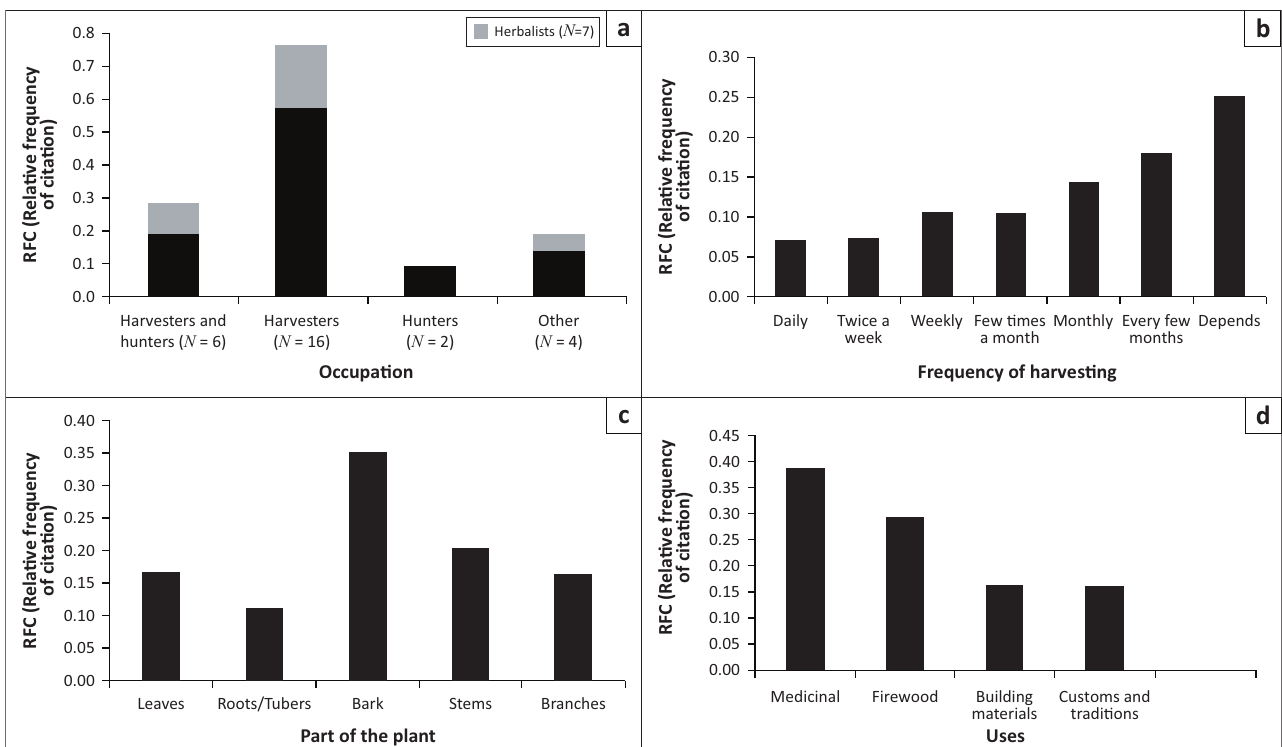
FIGURE 2: Relative frequency of citation of tree species harvested near the Pirie forest which are used as dens by the tree hyrax.